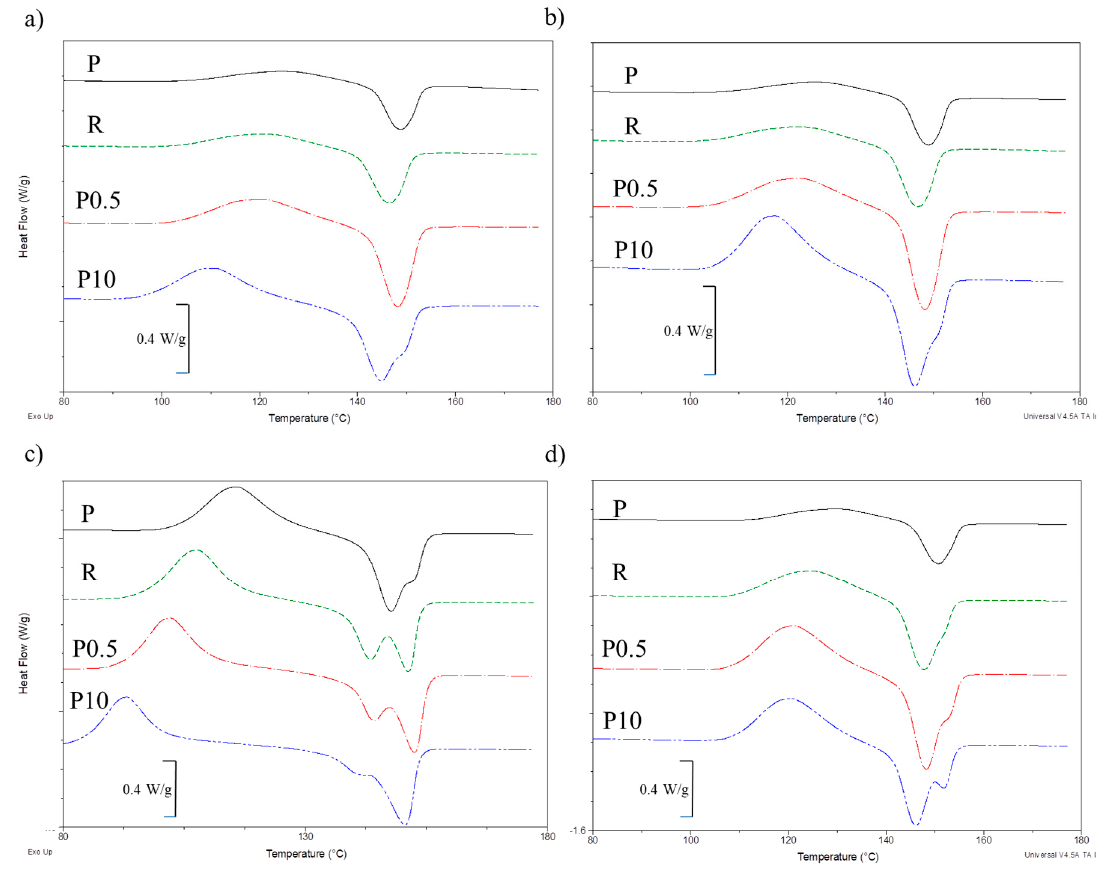
Figure 5. DSC curves of selected samples; ( a ) first heating of un-aged samples, ( b ) second heating of un-aged samples, ( c ) first heating of samples aged for 2160 h, and ( d ) second heating of samples aged for 2160